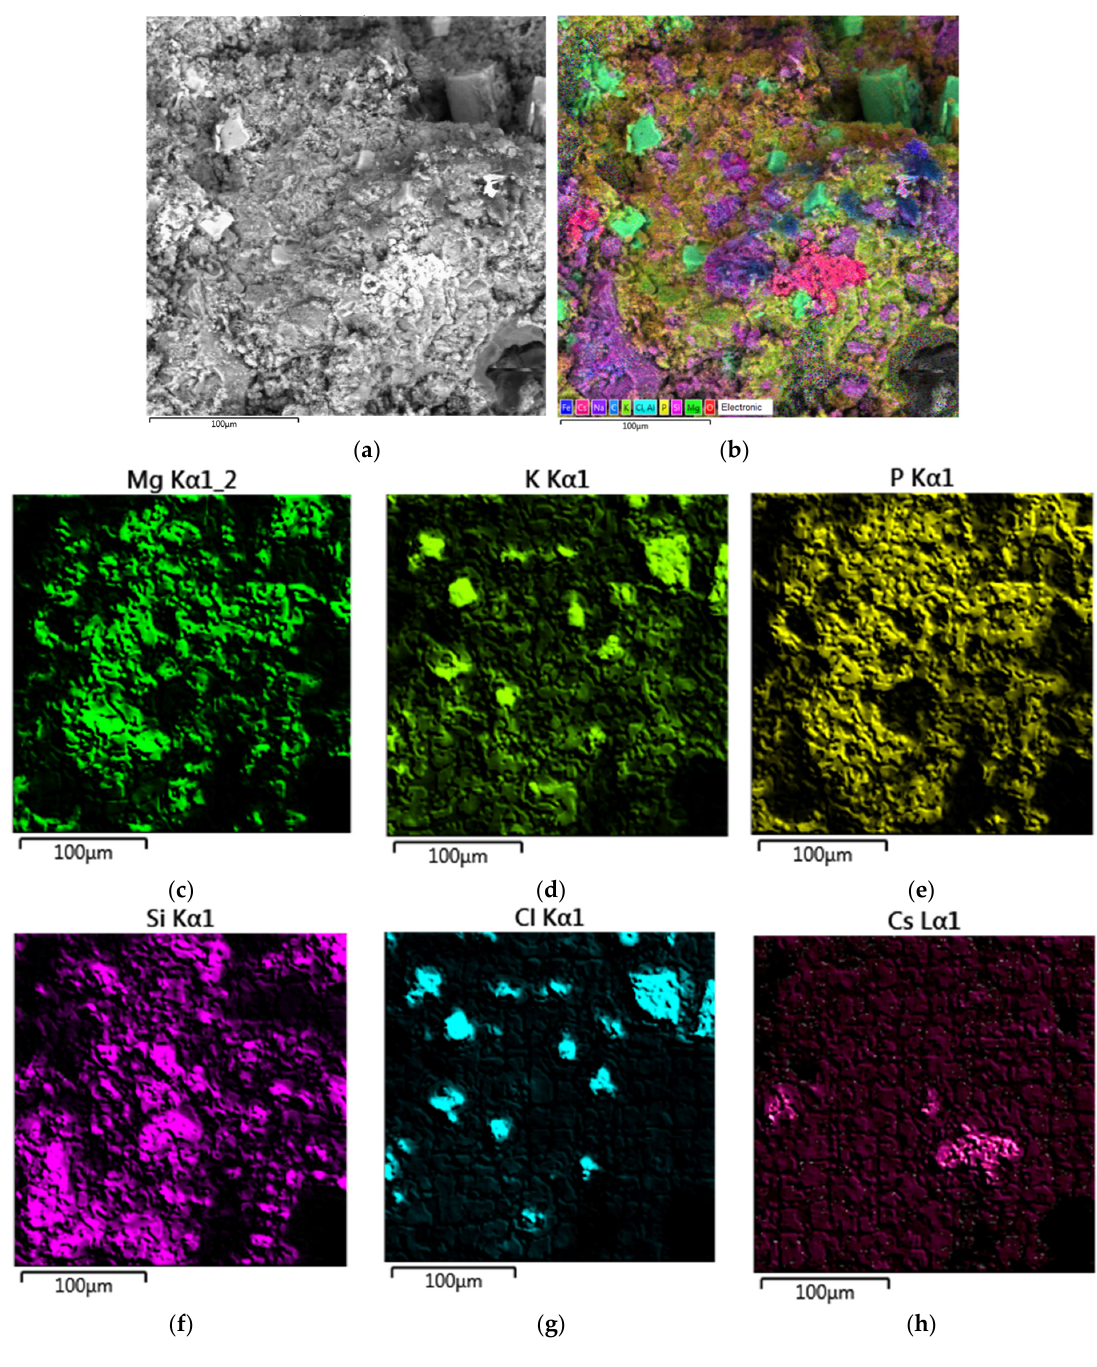
Figure 5. Scanning electron microscope images ( a ) and elemental mapping of major elements ( b–h ) of the MPPZ compound containing 20 wt% LiCl-KCl-CsCl and 28.6 wt% zeolite.